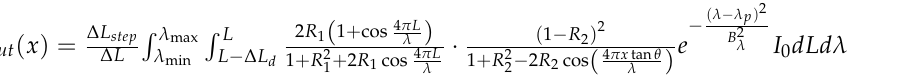
results from the